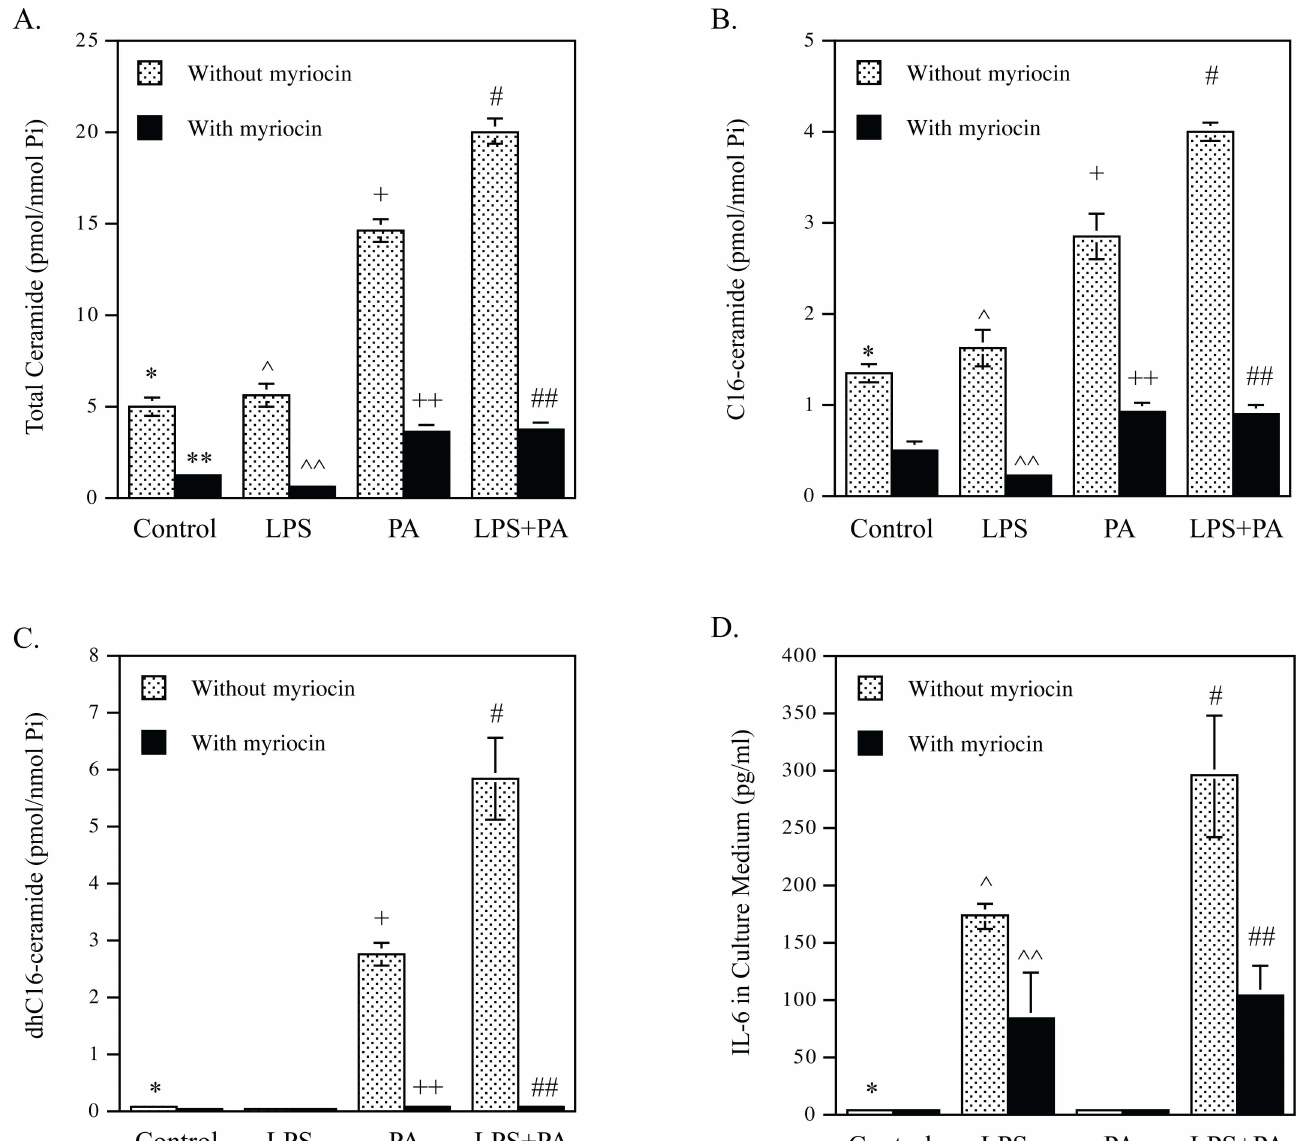
Fig 5. Myriocin inhibits IL-6 secretion stimulated by LPS or LPS plus PA. A-C. RAW264.7 macrophages were treated with 1 ng/ml of LPS, 100 μM of PA or both LPS and PA in the absence or presence of 10 μM of myriocin for 12 h. After the incubation, total (A), C16-CER (B) and dhC16-CER (C) were quantified using lipidomics. D. RAW264.7 macrophages were treated with 1 ng/ml of LPS, 100 μM of PA or both LPS and PA in the absence or presence of 10 μM of myriocin for 24 h. After treatment, IL-6 in culture medium was quantified using ELISA. (cid:3) vs. +, p < 0.01; (cid:3) vs. #, p < 0.01; (cid:3)(cid:3) vs. (cid:3) , p < 0.01; ^^ vs. ^, p < 0.01; ++ vs. +, p < 0.01; ## vs. #, p <